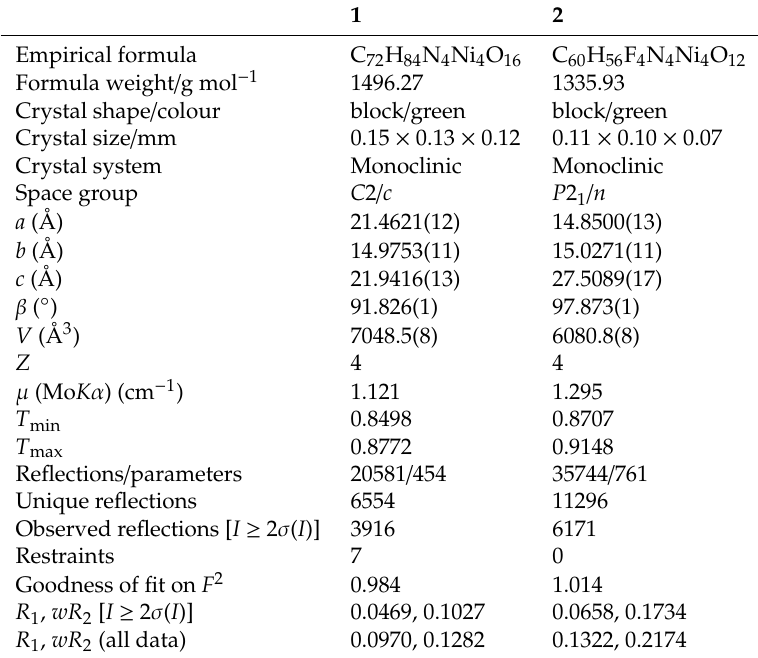
Table 1. Details of the data collection and refinement parameters for complexes 1 and 2 .